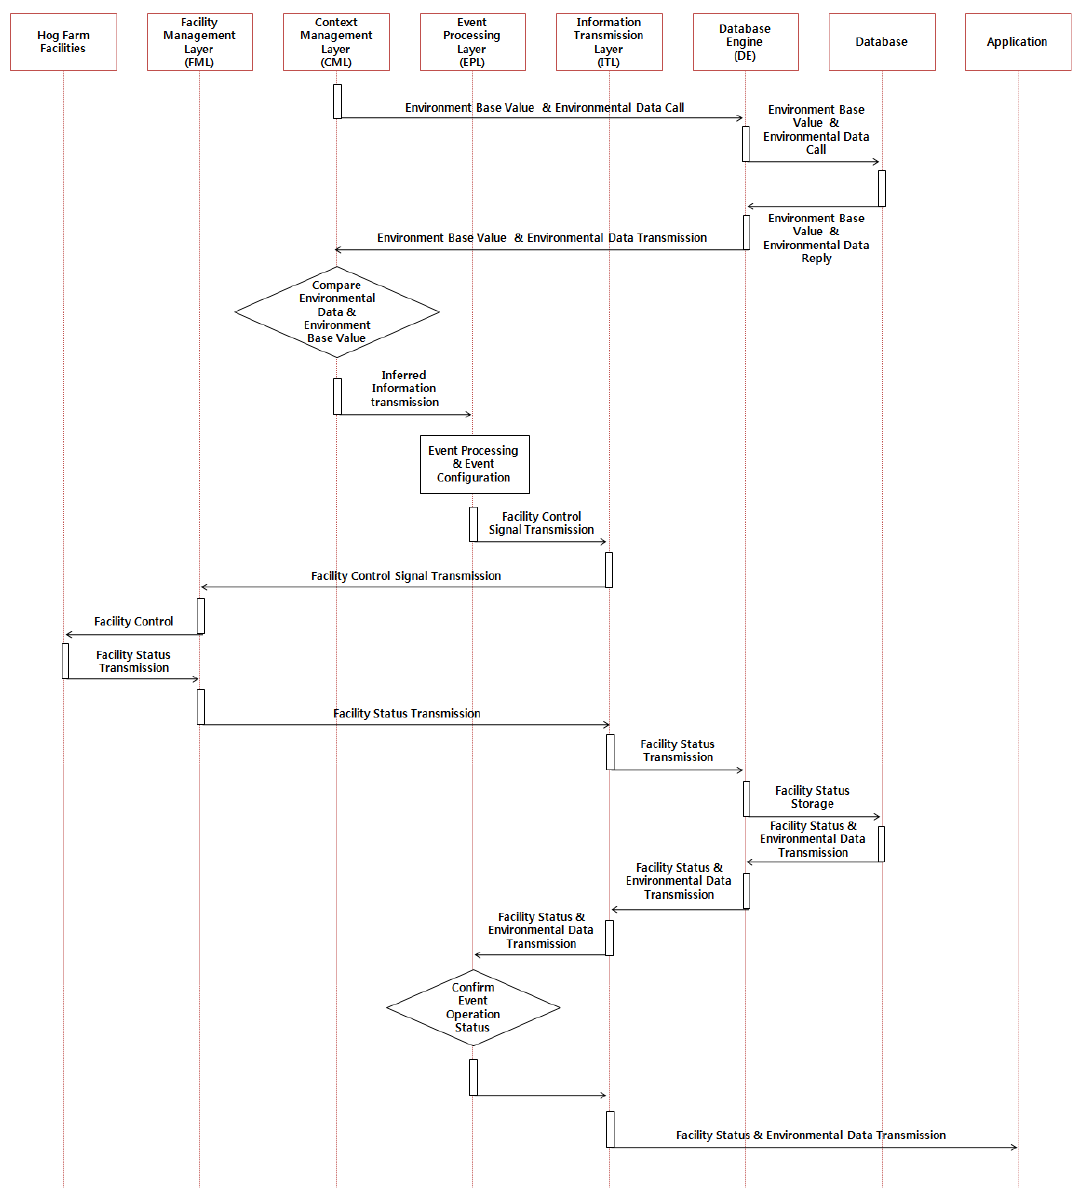
Figure 5. Operation Process of Hog Farm Facility Automatic Control